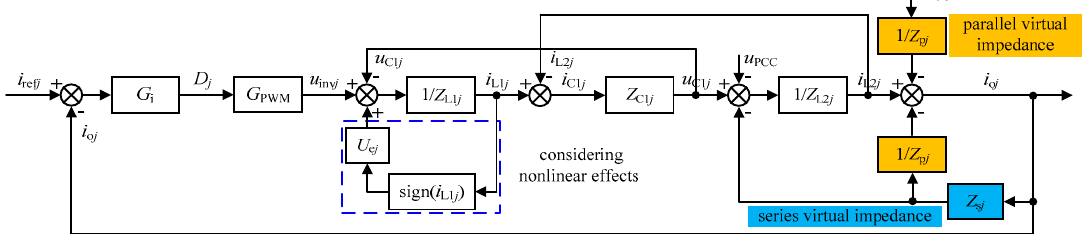
Figure 4. Equivalent control block diagram of oscillation suppression method by two notch filters for parallel inverters.